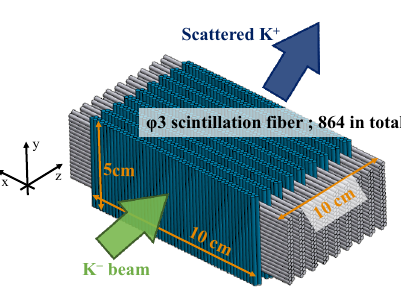
Fig. 2. Schematic drawing of AFT in J-PARC E70. AFT directly measures the energy losses of 𝐾 ! and 𝐾 " which are related to the Ξ - hypernuclear production event by event.